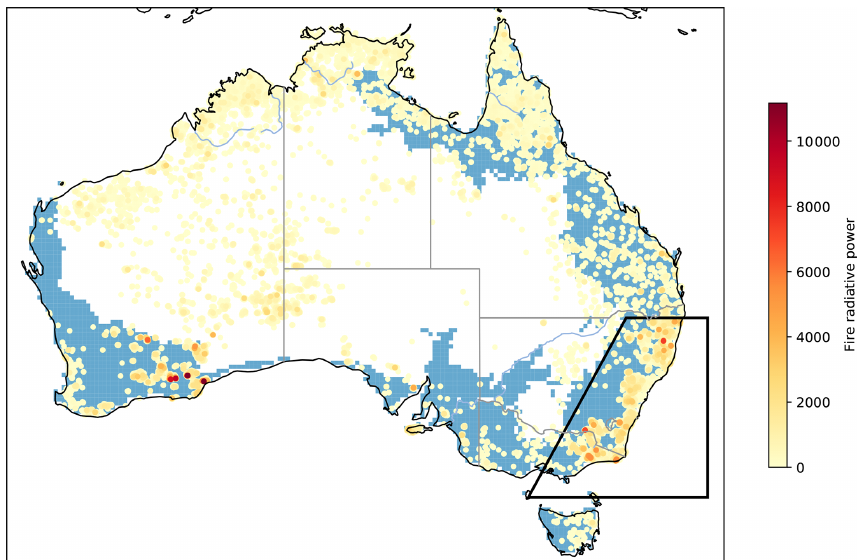
Figure 1. Moderate Resolution Imaging Spectroradiometer (MODIS) active fire data (Collection 6, near-real-time and standard products) showing the severity of bushfires from 1 October 2019 to 10 January 2020 with the most severe fires being depicted in red. The image also shows the forested areas in blue. The polygon shows the area analysed in this